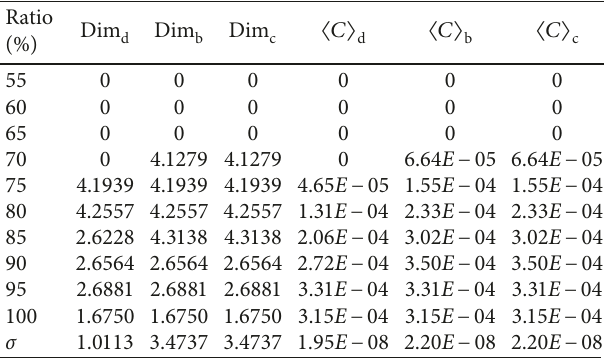
Table 2, and the cluster coefficient 〈 C 〉 listed in the 6th column of Table 2.